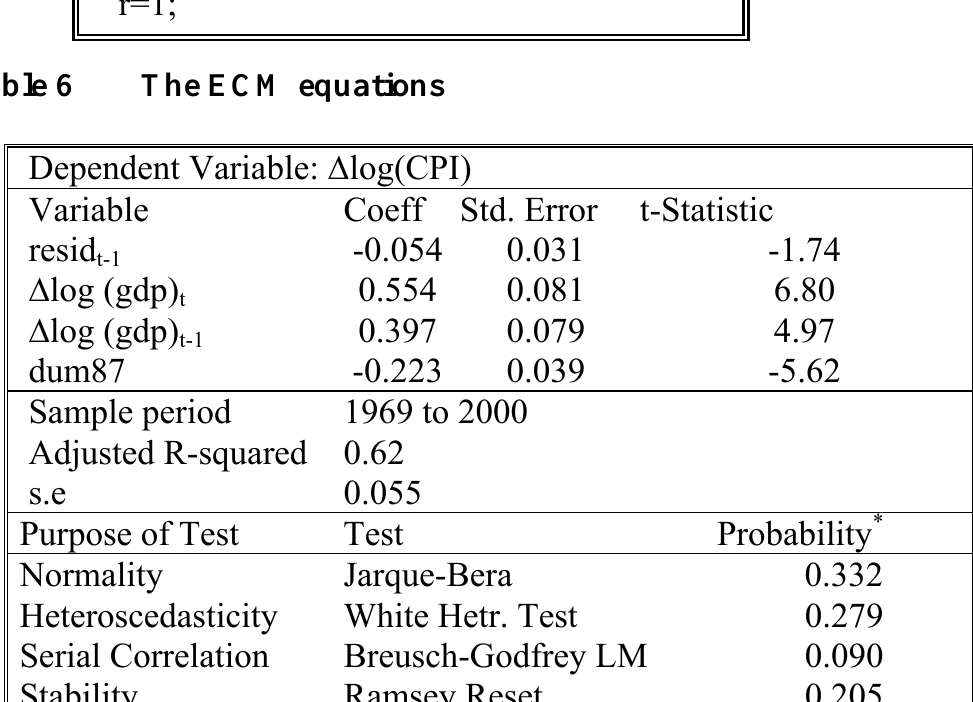
*Indicates the probability of falsely rejecting the null hypotheses of zero restrictions on the coefficient or